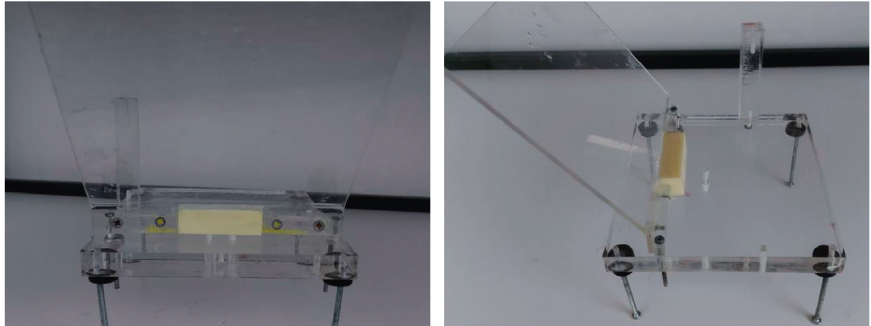
Figure 4: The design of the bracket. The special bracket was designed for holding the samples during the osteotomies, and a gingival protector was used also to isolate the surface where the temperature was measured in order to prevent the irrigation from interfering with the infrared camera readings and giving rise to measurement errors.